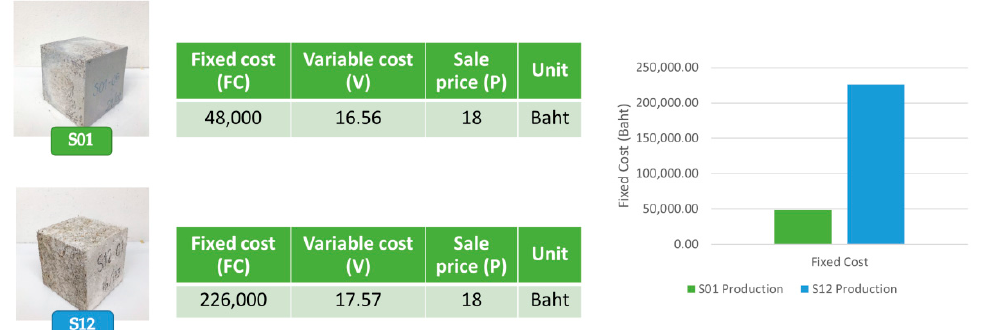
Figure 11. Cost comparison of the brick production between S01 and S12.